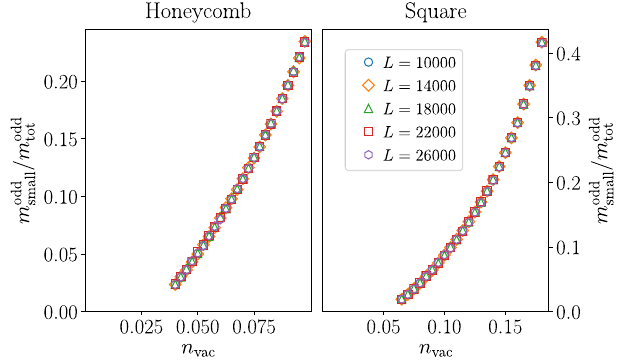
=m odd , where m odd is tot small small . This may be compared with results vac